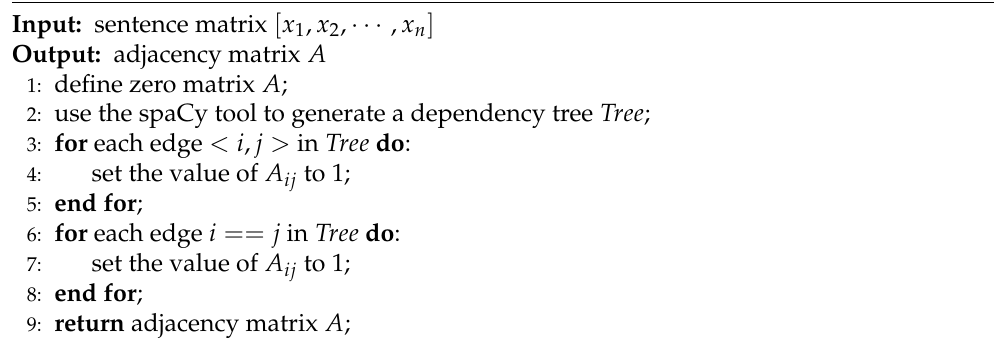
Algorithm 1 Syntactic information construction